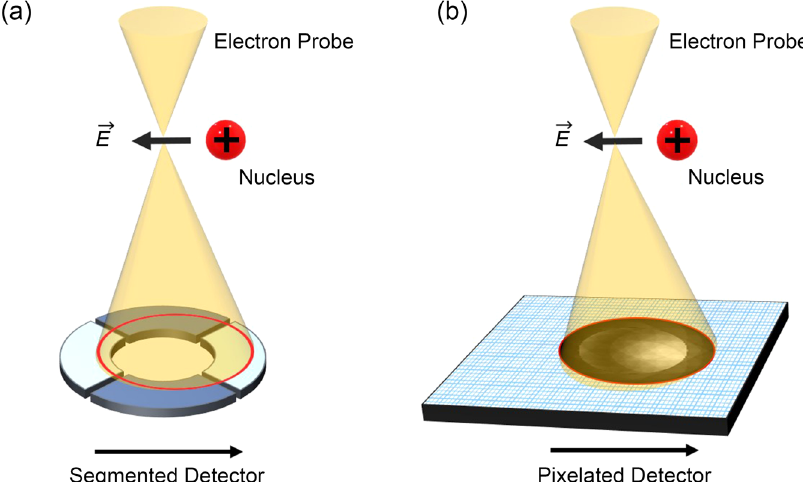
Fig. 8 Schematics depicting two different types of the setup for DPC and 4D-STEM. a DPC with a segmented detector and b 4D-STEM with a pixelated detector. When the electron probe passes through the electric fi eld pointing left, the intensity in the diffraction pattern shifts